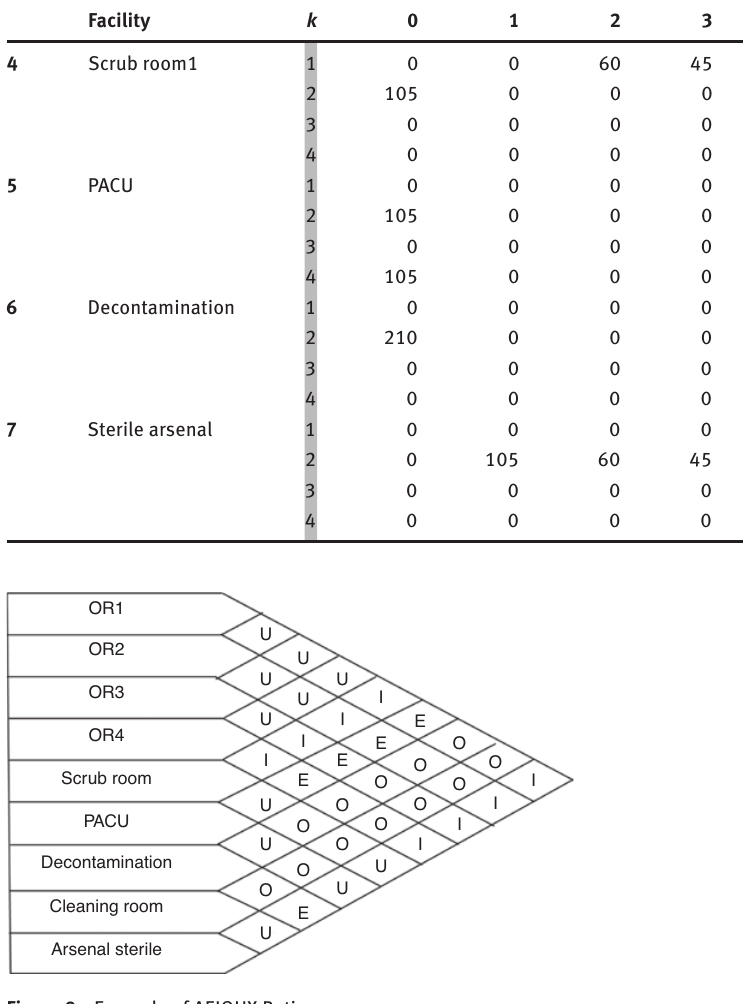
Figure 9: Example of AEIOUX Appendix Table 2: Trip Difficulty Rating Based on Movement Description and Entity Types.